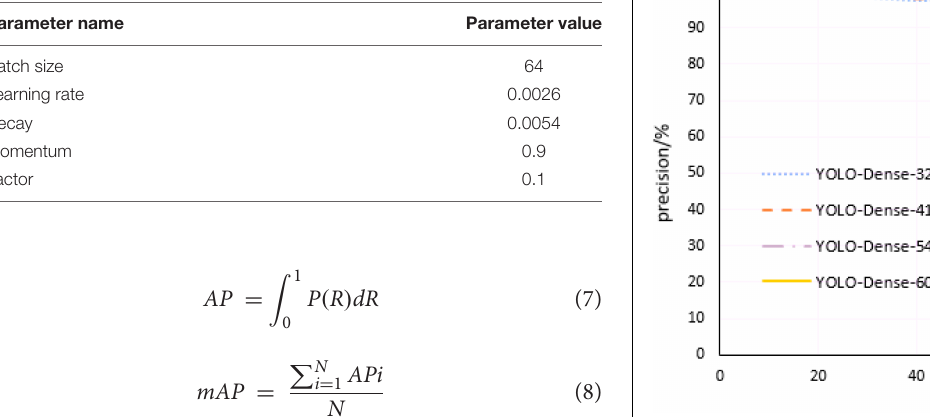
TABLE 1 | Selection of key parameters.